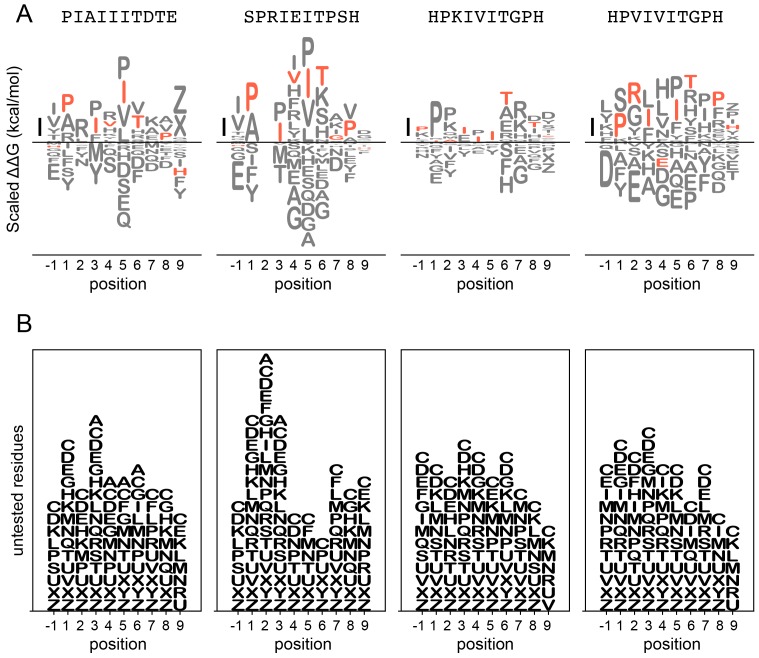
LogoMaker logos for binding data.Top: binding preferences for AKAP79 (left), NFATc2 (middle left), PKIVIT (middle right), and PVIVIT (right) represented as logos. Scale bar indicates a change in binding affinity of 1 kcal/mol; amino acids are arranged top-to-bottom in order of binding preference. Wild-type residues are shown in red; other residues are shown in grey. Bottom: Logos display residues not tested experimentally at each position to illustrate missing data.